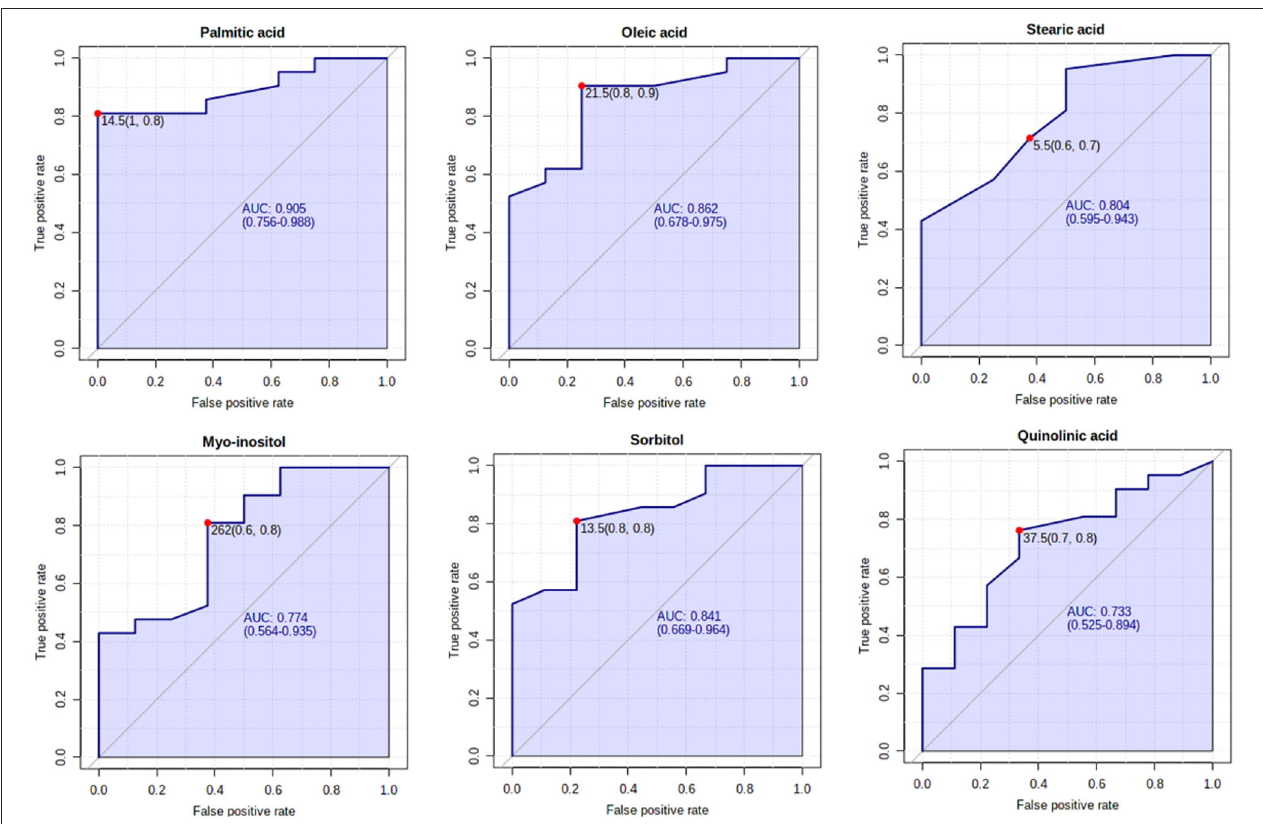
FIGURE 1 | The receiver operating characteristic (ROC) curves of significantly different metabolites between Parkinson’s disease (PD) cases and control subjects, with the area under the curve (AUC) >